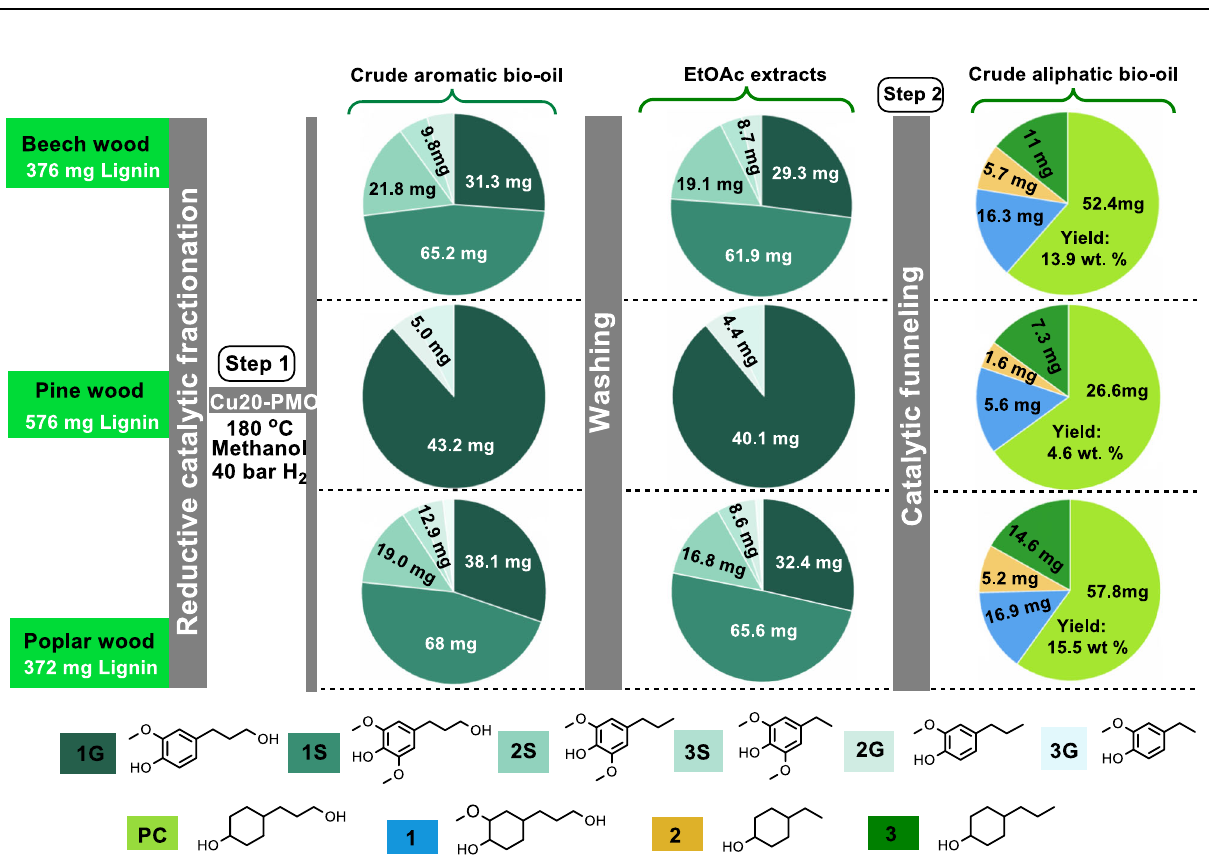
Fig. 3 A catalytic reaction protocol toward the production of PC directly from a crude RCF mixture of beech, pine, and poplar lignocellulose. Step 1: RCF of beech, pine, and poplar wood over Cu20-PMO catalyst to give crude aromatic bio-oil. The crude aromatic bio-oil was subjected to fractionation with EtOAc and washing with saturated NaHCO 3 and brine to give EtOAc extracts; Step 2: Catalytic funneling of EtOAc extracts to PC and other cyclohexane derivatives over Raney Ni/isopropanol. The yield was given based on lignin content. In this fi gure, only the volatile, monomeric products are displayed. More quanti fi cation, analysis, and characterization details can be found in Supplementary Note